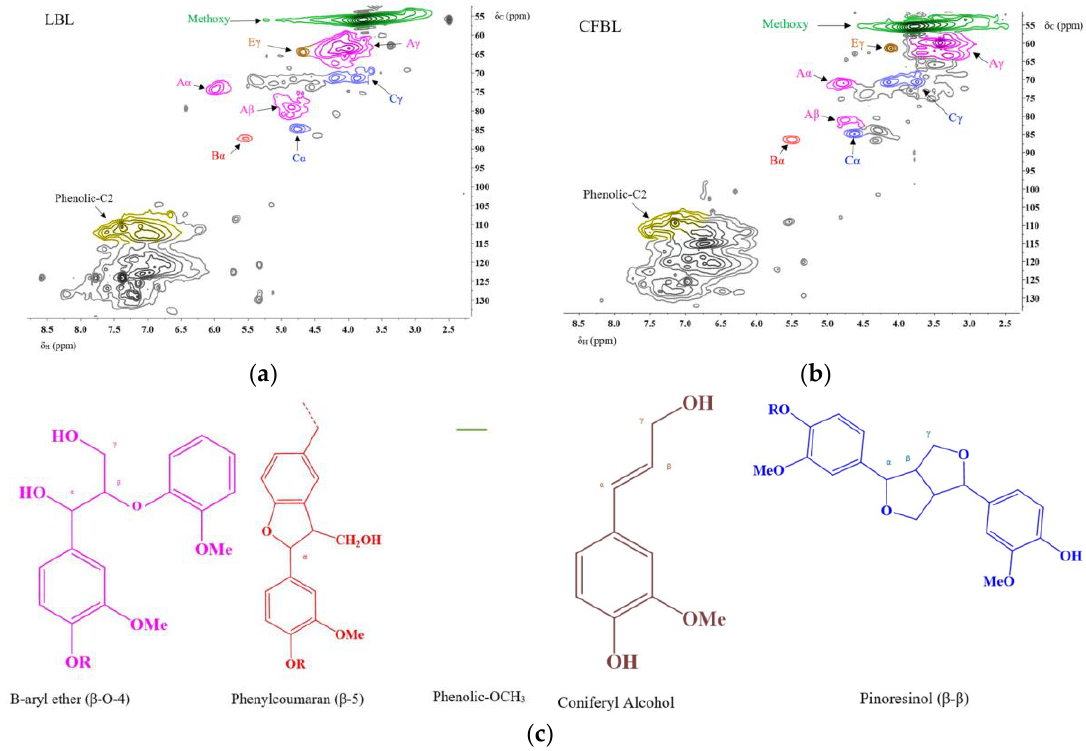
Figure 2. Interunit analysis by 2D-NMR for the: ( a ) LBL and ( b ) CFBL lignin samples; ( c ) assignments.